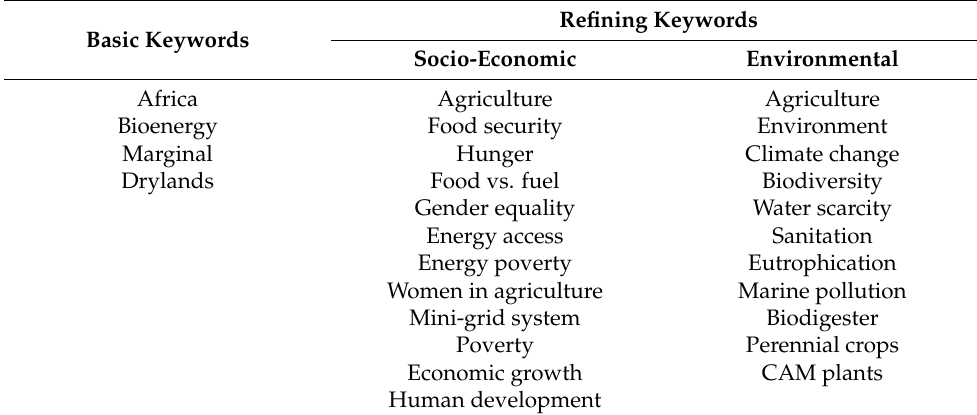
Table 1. Overview of basic and refining keywords used for the literature search in this